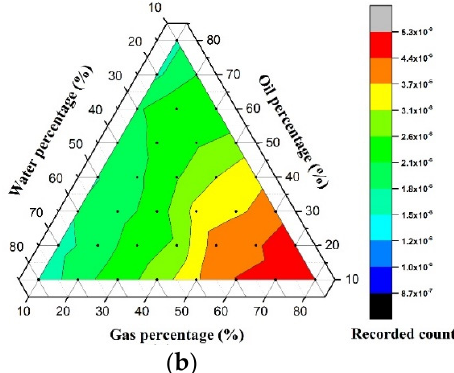
Figure 2. Recorded counts under Photopeaks of ( a ) 241 Am and ( b ) 133 Ba radioisotope in the second detector for different combed oil, gas and water volume fractions at thickness scale of 0 cm.